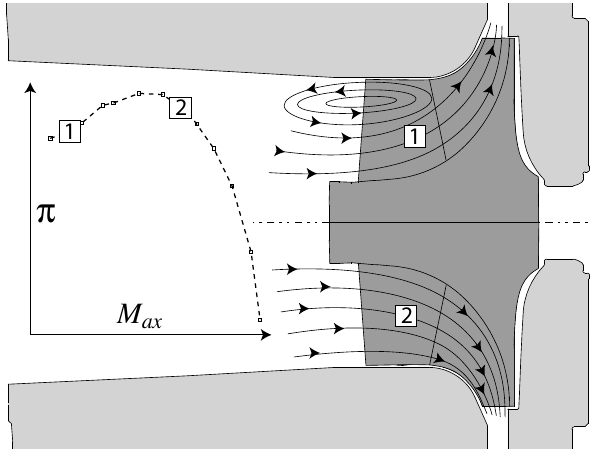
Figure 2. Schematic of impeller flow for nominal (2) and close to surge (1) operation incorporating inducer